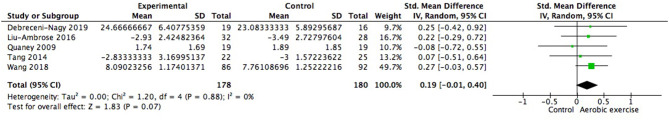
Meta-analysis of effect of aerobic exercise on working memory.